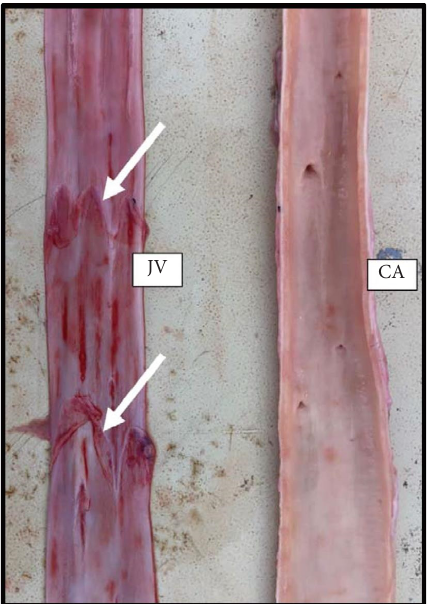
Figure 6: Photograph of the girafe jugular vein (JV) with valves indicated by white arrows and the common carotid artery (CA) without valves.